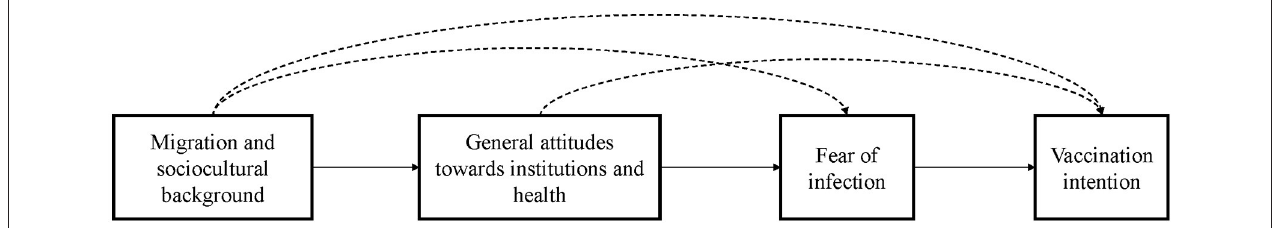
FIGURE 1 | Hypothetical structure of vaccination